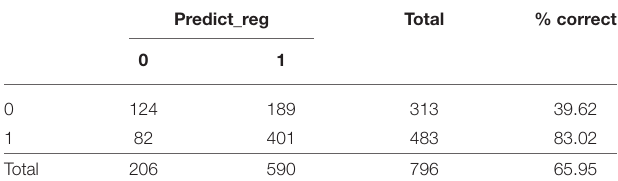
TABLE 7 | Logistic regression results in Mainland China.